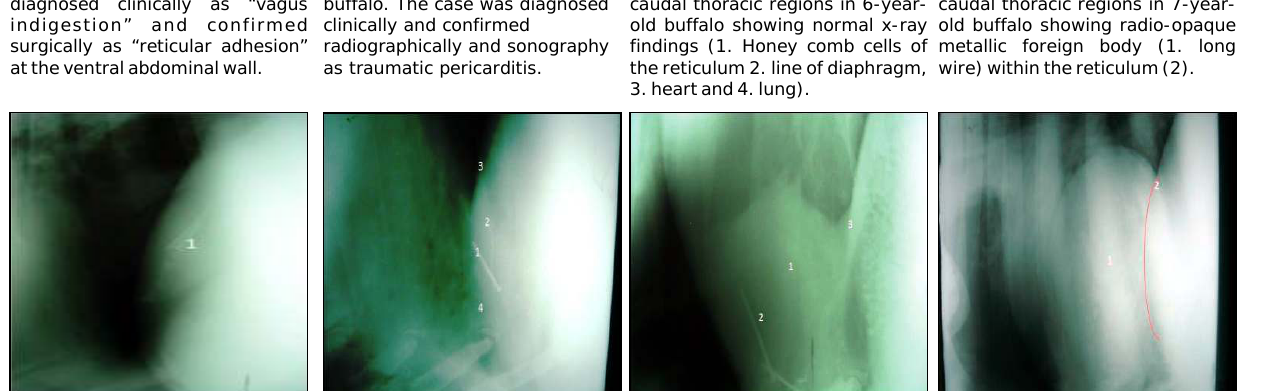
Figure-6. Lateral plain radiography of the cranial abdominal and caudal thoracic regions in 9-year- old buffalo showing radio-opaque metallic foreign bodies (1. nail and 2. long wire) at the diaphragmatic surface of the reticulum (3) associated with adhesion between the ventral aspect of the diaphragm and the apex of the heart (4).